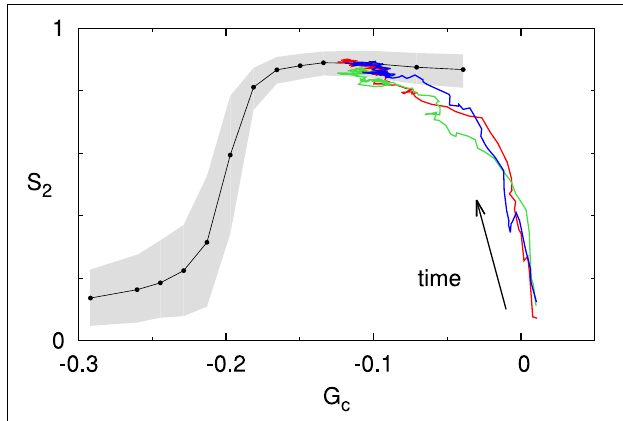
FIGURE 10 | Finite tubulin pool. The colored traces show three independent runs initiated in the unbounded growth regime ( G c > 0; with r c = 0 . 0025 s − 1 ). Note that all three runs converge to the steady state G c – S 2 curve computed for these interaction parameters (black line). The gray area denotes the 10–90% range for a set of n = 500 simulations at t = 20h.